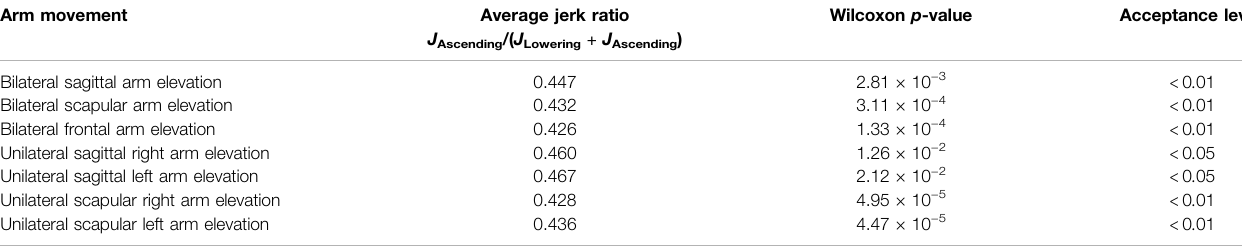
TABLE 5 | Comparisons of jerk metrics between ascending and lowering phases of bilateral and unilateral arm elevation. Arm movement